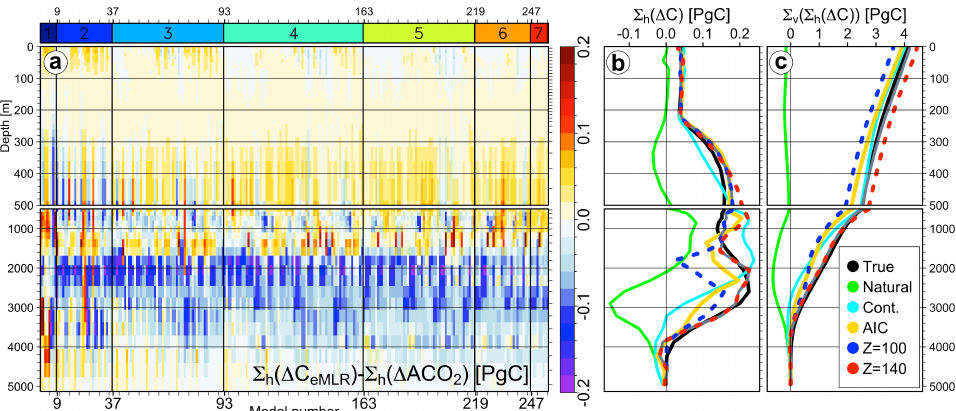
Fig. 8. (a) Absolute errors between the North Atlantic eMLR predicted inventory change, mapped from estimates at GLODAP stations, and the true inventory changes integrated on each horizontal model layer ( 6 h ) and for each first order regression model (strategy 2). (b) Ver- tical profiles of the layer inventory changes and (c) vertically integrated layer inventory change (from the bottom to the surface, 6 v ). The true, natural and contemporary (Cont.) layer inventory changes between July 1995 and July 2005 are shown, together with the “best AIC” composite solution and results from models Z 100 and Z 140 (dotted) and their merged products spliced at 1500m